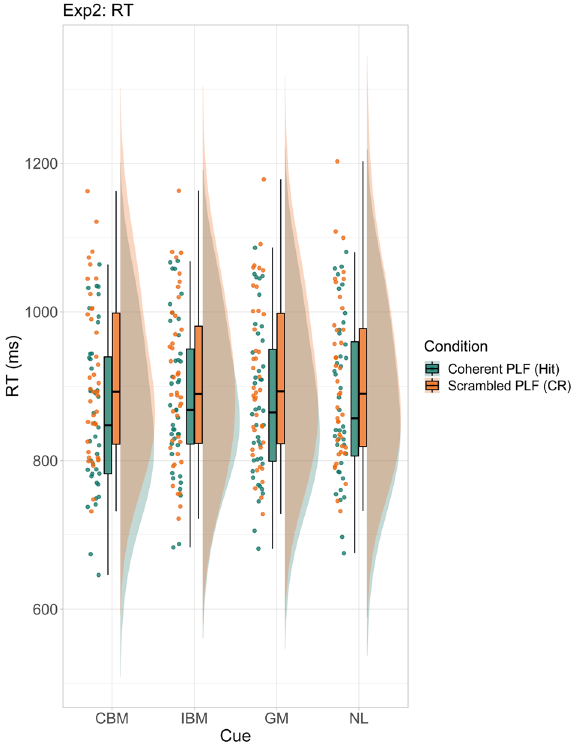
Figure 5. RTs (raw data) for coherent and PLF conditions for Experiment 2. Cue names are as follows: CBM congruent biological motion, IBM incongruent biological motion, GM general motion, NL no